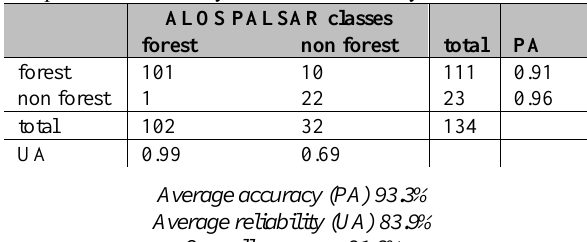
Table 2. Confusion table for a forest/non-forest classification. PA: producer’s accuracy. UA: user’s accuracy.